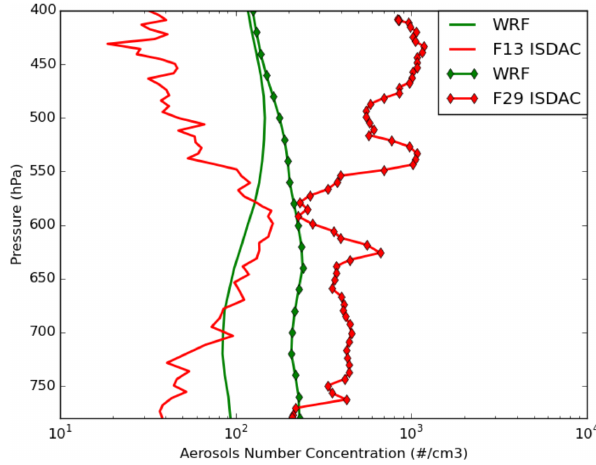
Figure 3. Comparison of the observed (red) and simulated (green) WRF vertical profiles of total aerosol number concentrations. Ob- servations were measured by the PCASP in situ sensor onboard the Convair-580 just before entering the clouds for flights F13 (solid lines) and F29 (solid lines with diamond markers) Note that PCASP measurements were not available during flight